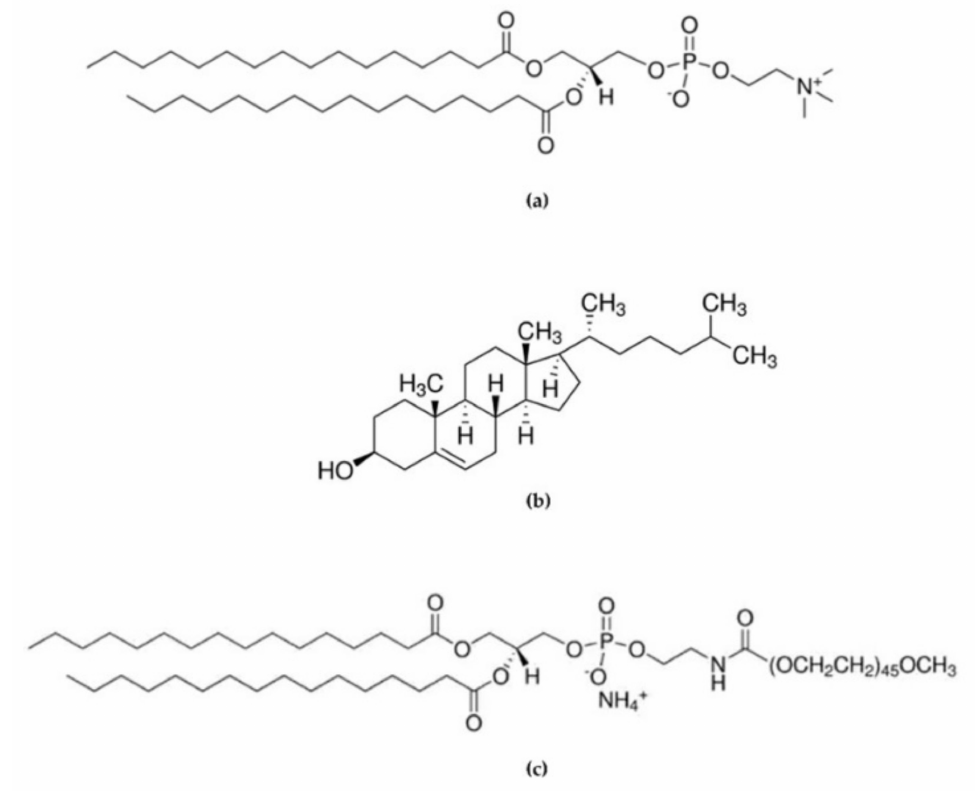
Figure 1. Chemical structure of ( a ) 1,2-Dipalmitoyl-sn-glycero-3-phosphocoline